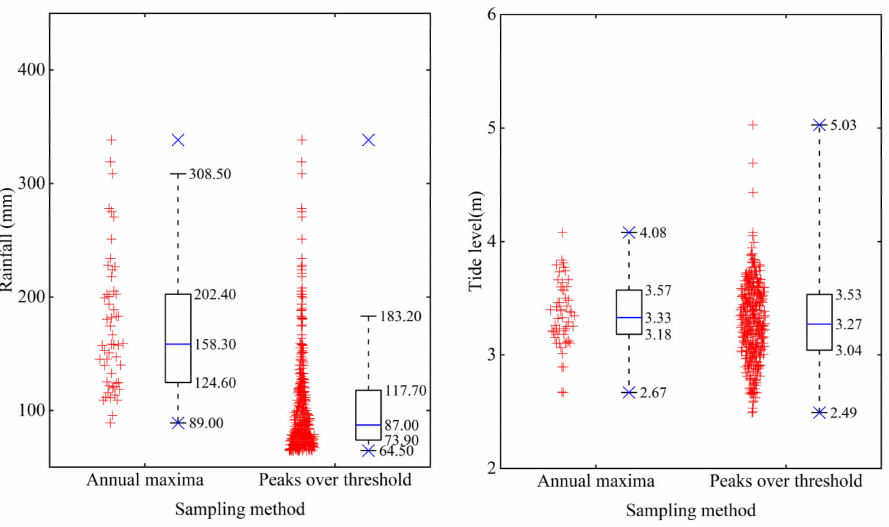
Figure 3. Fundamental statistical characteristics of the extreme rainfall and corresponding high tide series obtained using the two sampling methods. Scattered red crosses are the measured values, and the boxplot shows the statistical characteristic values. The lower and upper boundaries of the box represent the 25% and 75% quantiles, respectively. The blue solid line in the box is the median, the lines at both ends of the dotted line are the upper and lower limits of the normal values, and the blue “ × ” represents the maximum and minimum values of the